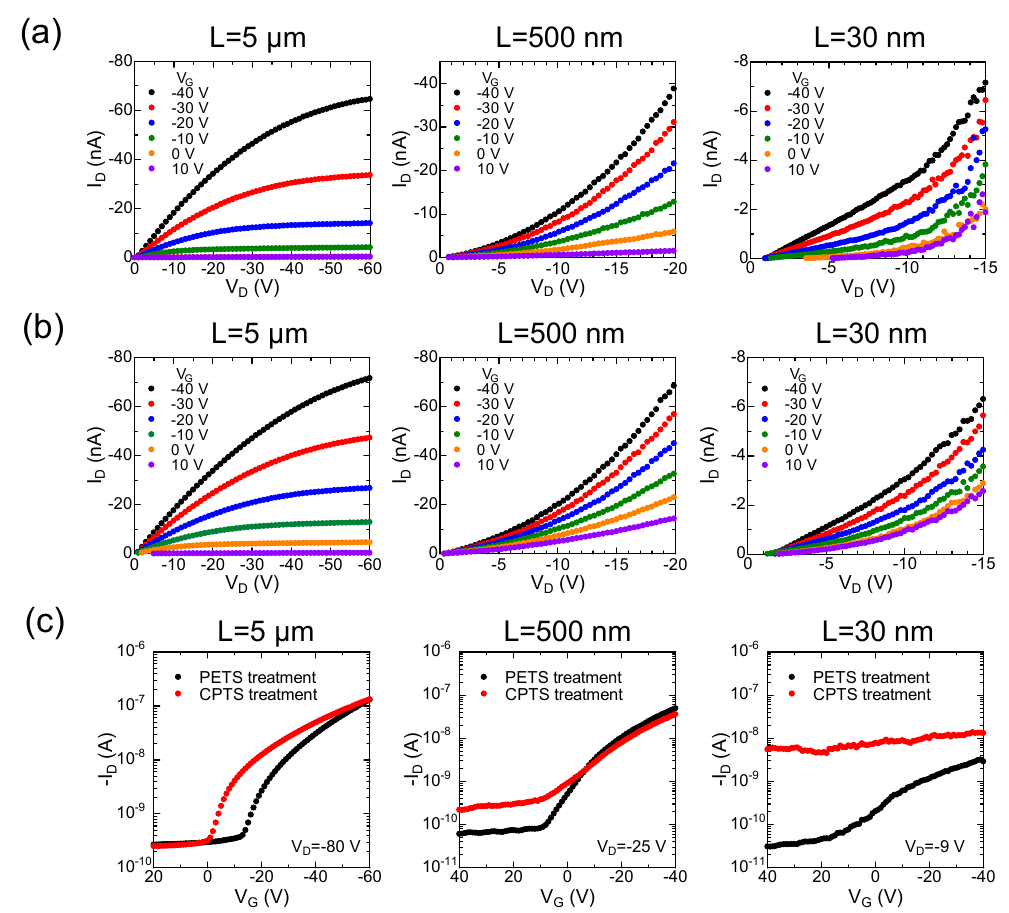
Figure 2. Output characteristics of P3HT FETs with L of 5 μ m, 500 nm, and 30 nm on 200-nm-thick SiO 2 insulators treated with ( a ) PETS and ( b ) CPTS; and ( c ) their transfer characteristics.